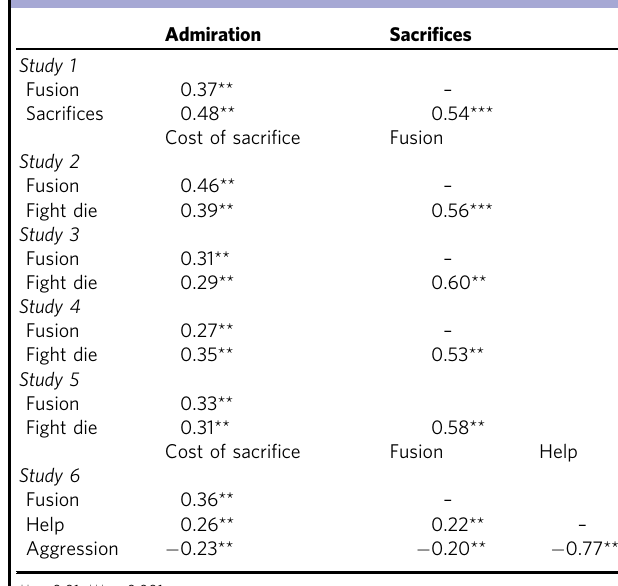
Table 2 Bivariate correlations for studies 1 – 6.